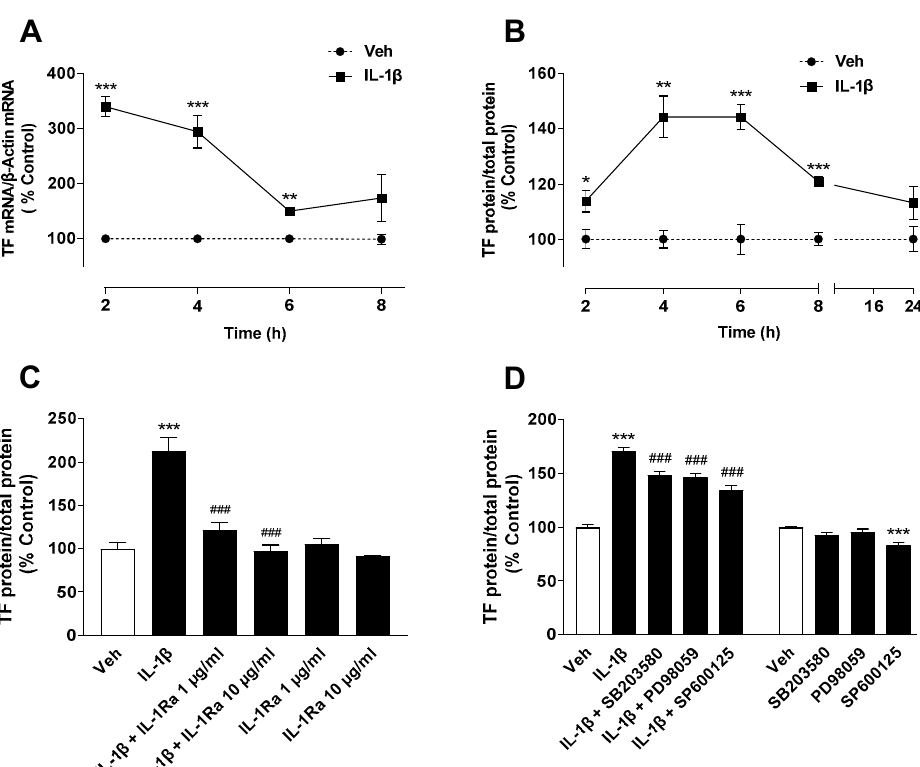
Figure 1. IL-1 β induces TF expression in A549 cells, which is completely abolished by IL-1 receptor antagonism and partially by inhibition of p38 MAPK, p42/44 MAPK and JNK. Time course of IL-1 β -induced TF mRNA ( A ) and TF protein ( B ). Effect of IL-1Ra ( C , at indicated concentrations) and SB203580, PD98059 and SP600125 ( D , all at 10 µ M) on IL-1 β -induced or basal TF protein. The cells were incubated in the presence or absence of IL-1 β (10 ng/mL) for the indicated periods ( A , B ) or preincubated with the respective inhibitor for 2 h ( C ) or 1 h ( D ) and then coincubated with IL-1 β or vehicle for 6 h. All percentage values shown refer to the respective vehicle control, which was set to 100%. The data represent mean values ± SEM of n = 4 ( A , B ), n = 3 ( C ) or n = 8 ( D ) experiments per group. * p ≤ 0.05, ** p ≤ 0.01, *** p ≤ 0.001 vs. corresponding vehicle control; ### p ≤ 0.001 vs. IL-1 β ; Student’s t test ( A , B ), one-way ANOVA with Bonferroni’s post hoc test ( C , D , left columns) or one-way ANOVA with Dunnett’s post hoc test ( D , right columns).